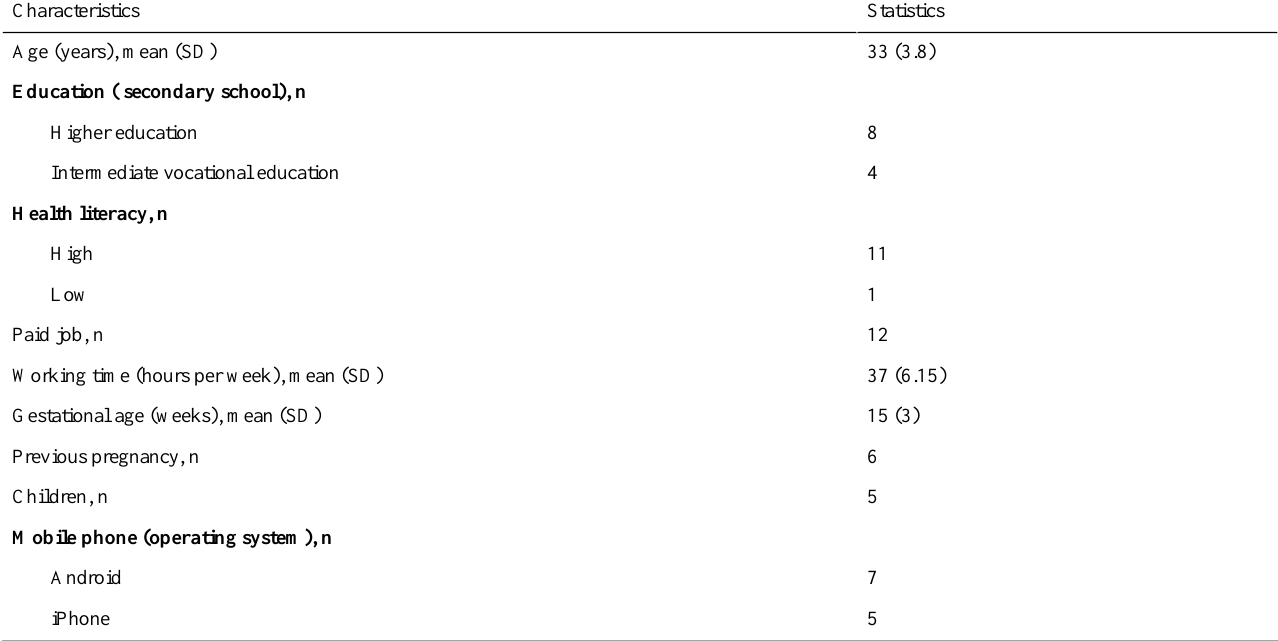
Table 1. Participants’basic demographics and characteristics (N=12).